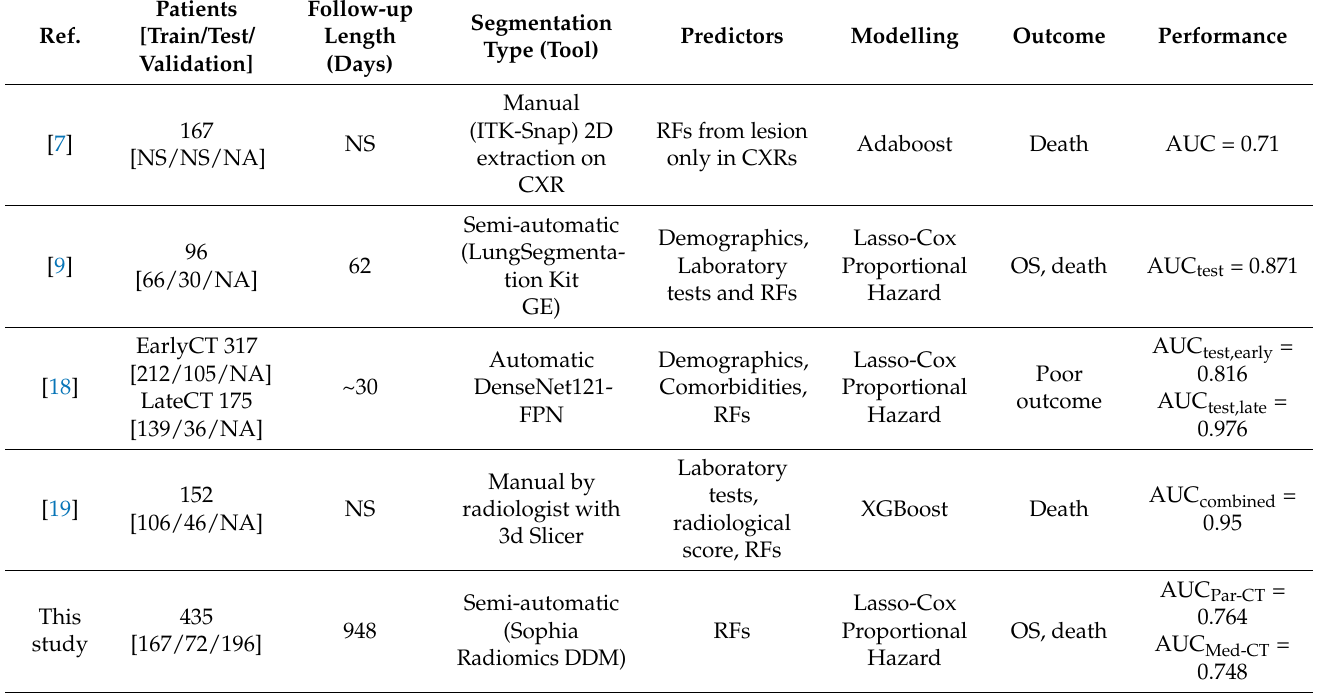
Table 2. Comparison of similar